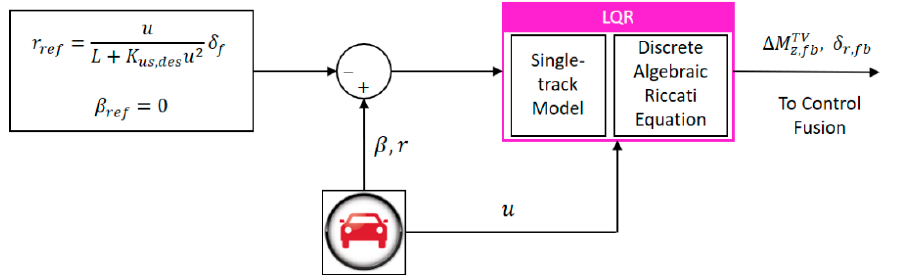
Figure 8. Block diagram of feedback controller.